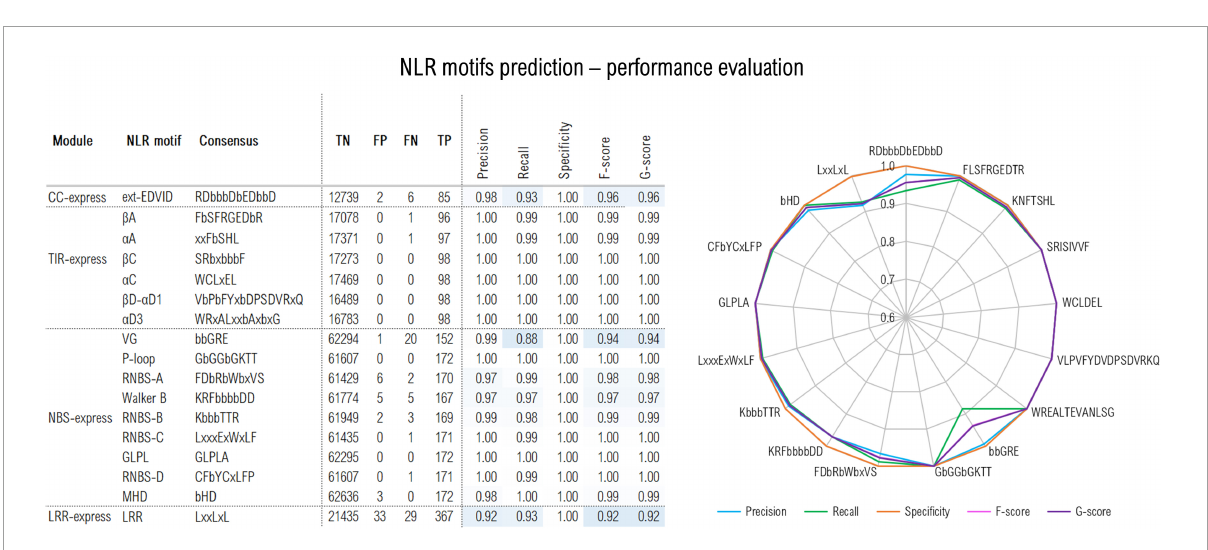
FIGURE2 Out-of-sample performance of the NLRexpress predictors on the test set (TP, true positive; TN, true negative; FN, false negative; TP, true positive). Cross-validation out- and in-sample performance results are shown in Supplementary Table 1 .